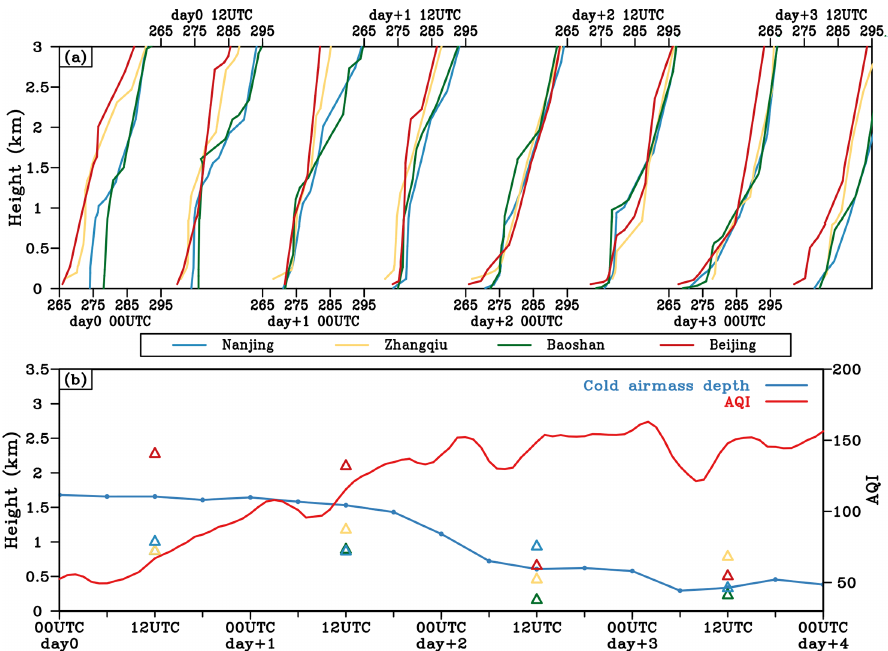
Figure 7. (a) Vertical profiles of potential temperature at four stations (from north to south are Beijing, Zhangqiu, Nanjing, and Baoshan) during a CAO rapid event from 14 to 17 December 2016. (b) Time series of the regional averaged cold air mass depth and the AQI in NEC and MLH (colored triangles) at four stations during a CAO_rapid event from 14 to 17 December 2016.